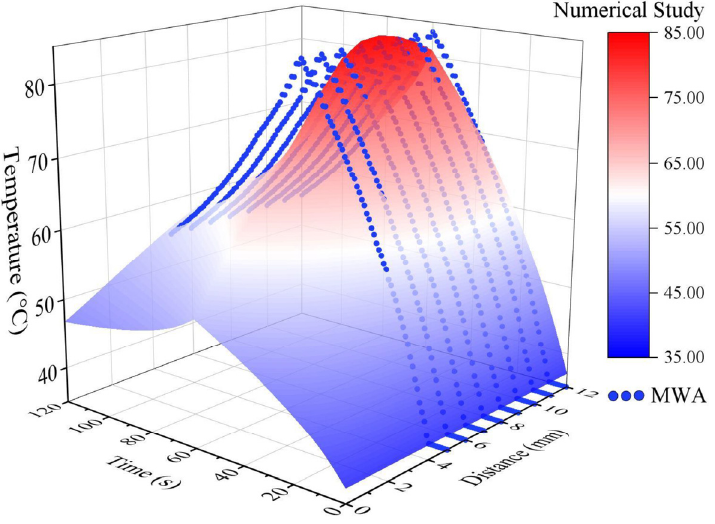
Figure 2. Temperature distribution at thermometric sequence near ablation antenna and MWA.